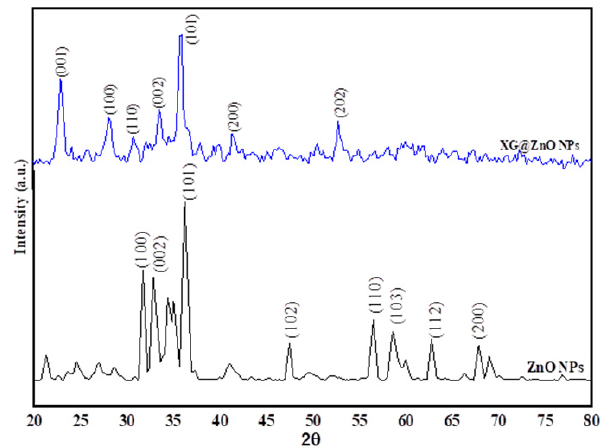
Figure 4. XRD spectra of ZnO (black line) and ZnO@XG (blue